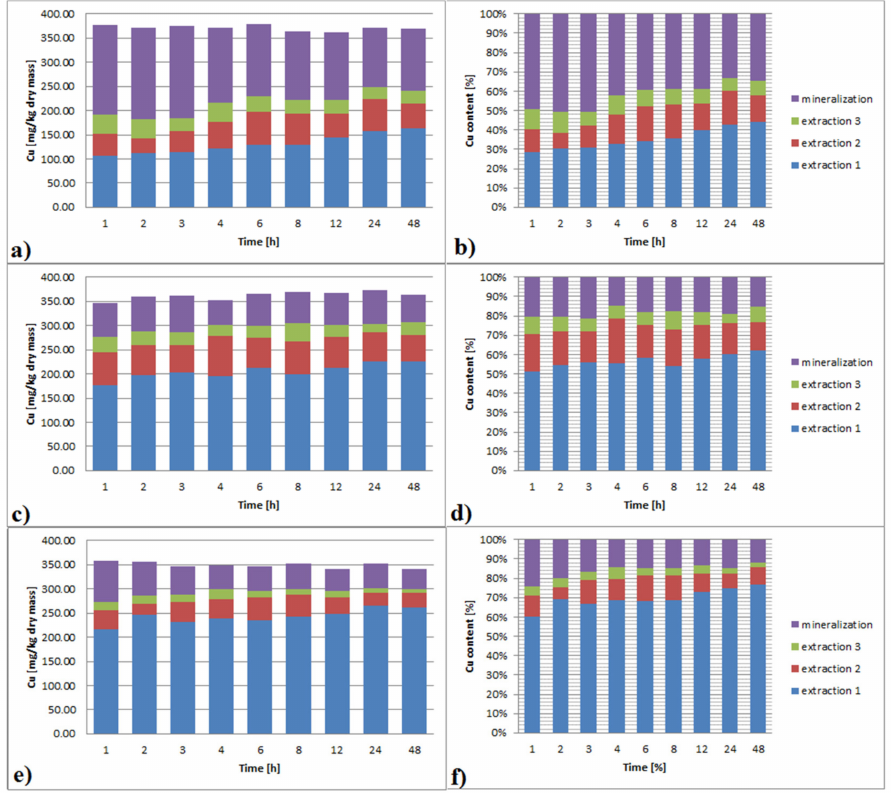
Figure 5. ( a – f ) . Cu extraction from bottom sediments with different EDTA concentrations ( a , b ): 0.01 M; ( c , d ): 0.05 M; ( e , f ): 0.1 M and extraction